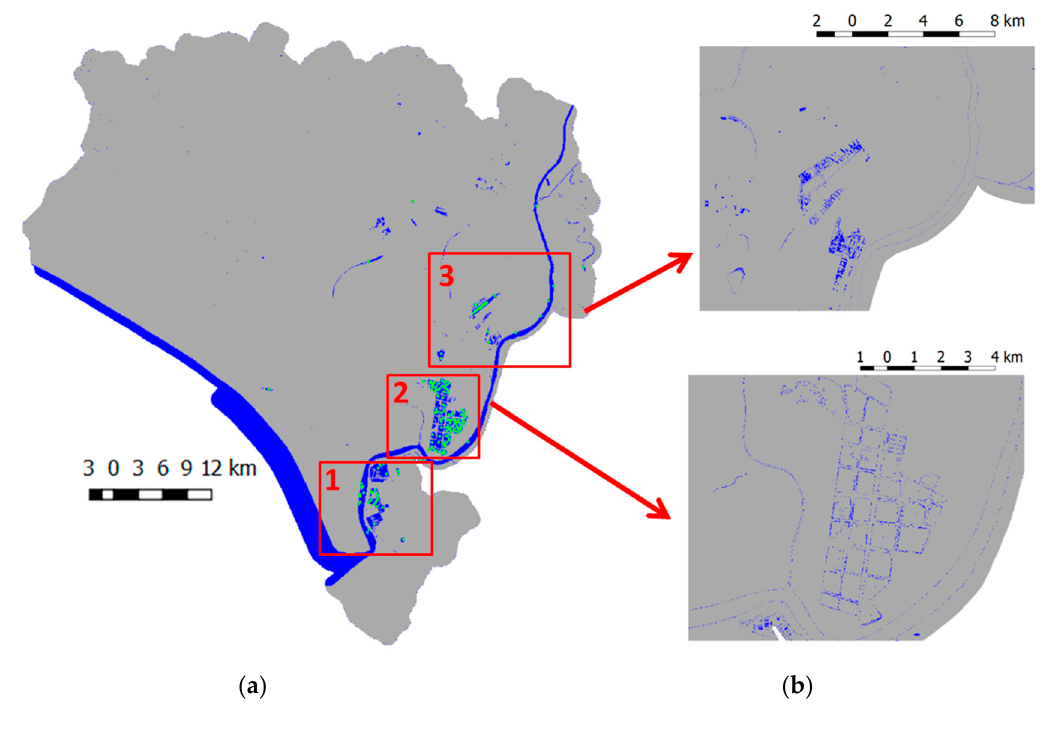
Figure 4. Histogram of the SWIR band. T init is the SWIR value for which the first valley in the SWIR histogram is detected (black point). The red point on the SWIR histogram corresponds to the final SWIR threshold T final . The valley right after the first valley in the SWIR histogram corresponds to threshold T upper . The peak between T final and T upper valley corresponds to threshold T peak (SWIR values reach up to 255, however, since there are a few pixels with a SWIR value over 120 that do not cause fluctuations of the SWIR histogram curve, the upper limit of the x-axis is set to 120 for visualization